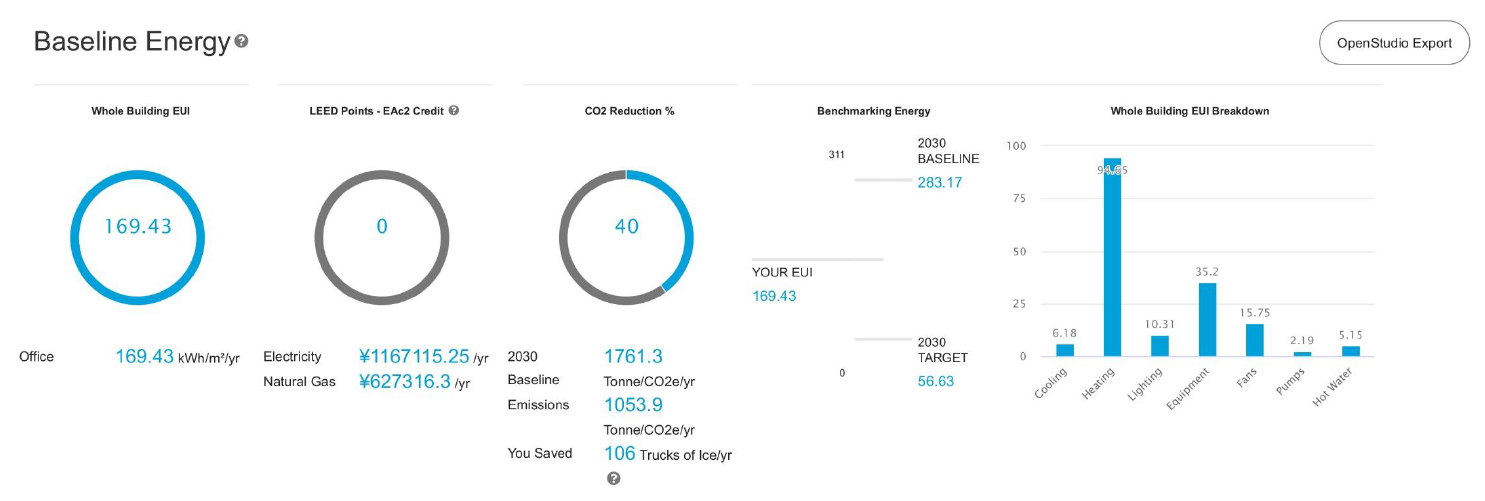
Figure A9. Zone 3-A Shanghai, Shanghai (post-COVID-19 84% scenario).